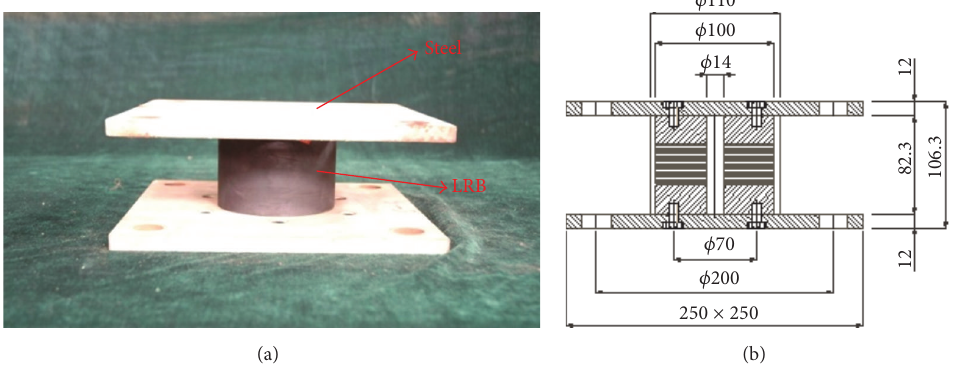
Figure 9: LRB100 bearing used in test: (a) specimen; (b)